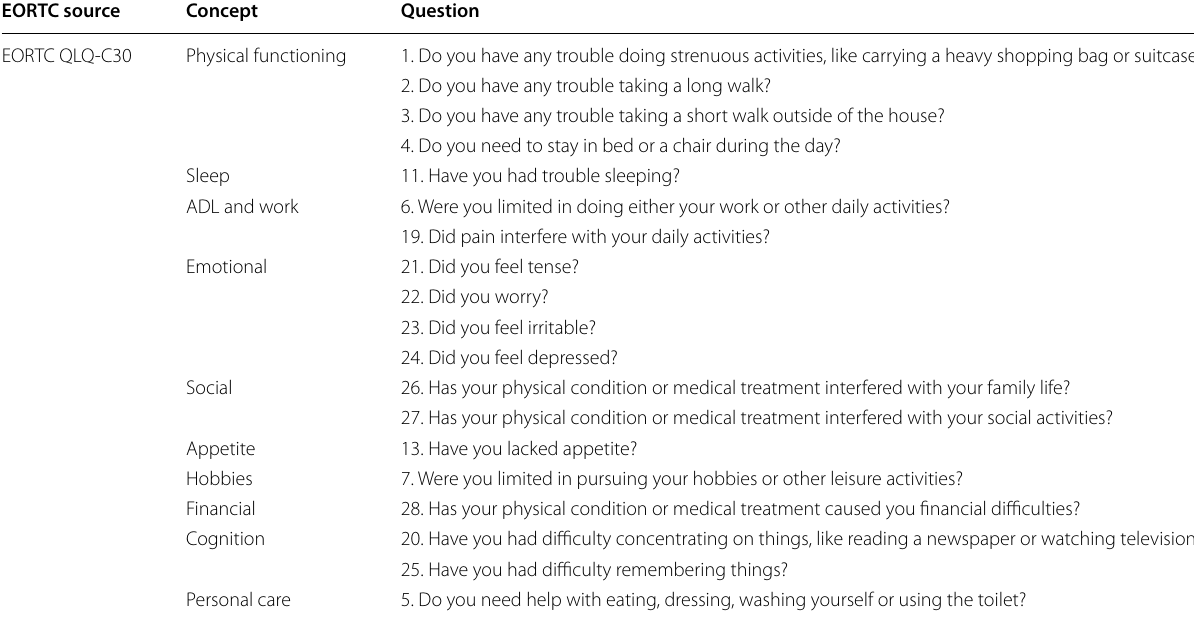
Table 2 Impact items used in the